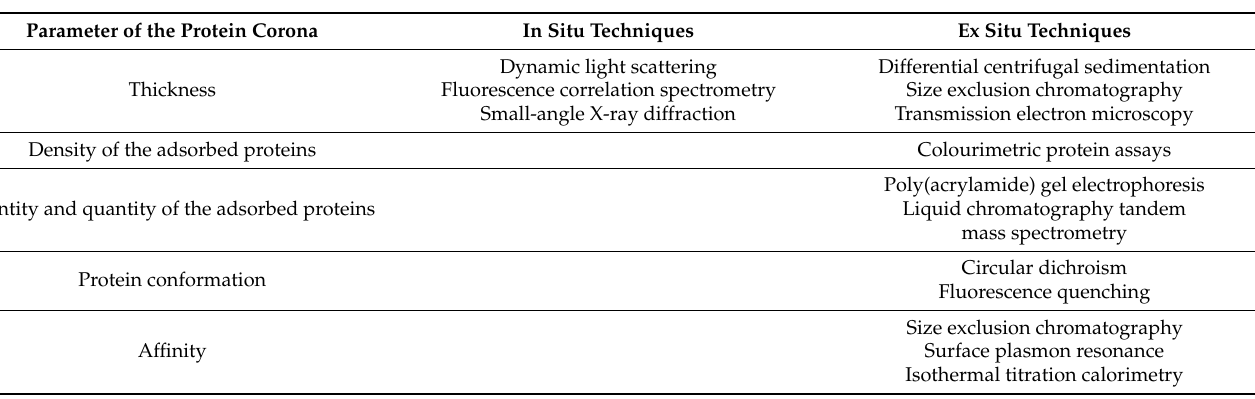
Table 3. Selected protein corona parameters and methods for their assessment